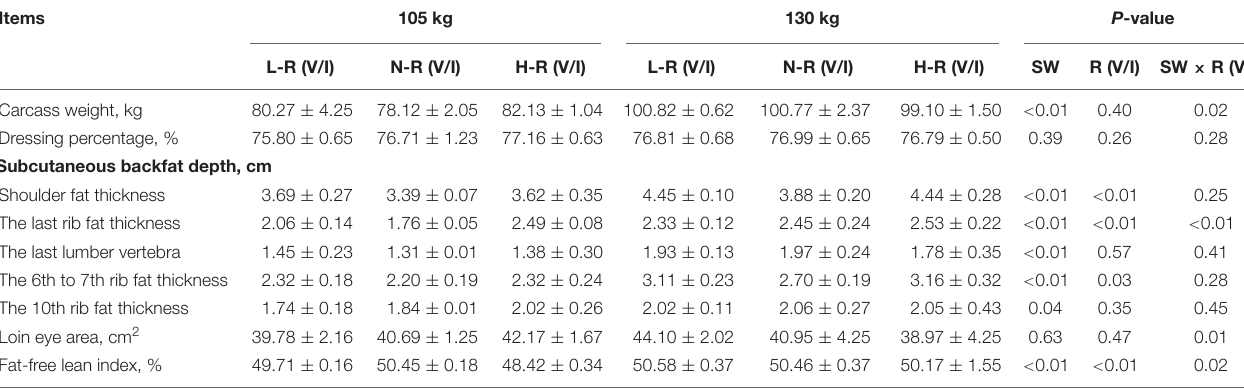
TABLE 2 | Effect of dietary R (V/I) and slaughter weight on the carcass traits in finishing pigs ( n = 6).